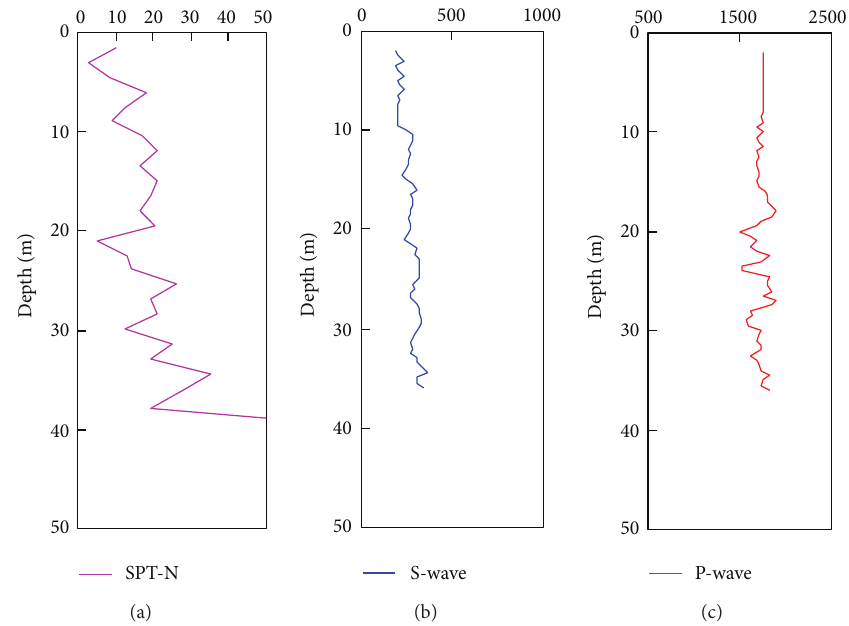
Figure 2: A typical example of geological test result (checking station CS25, A7).